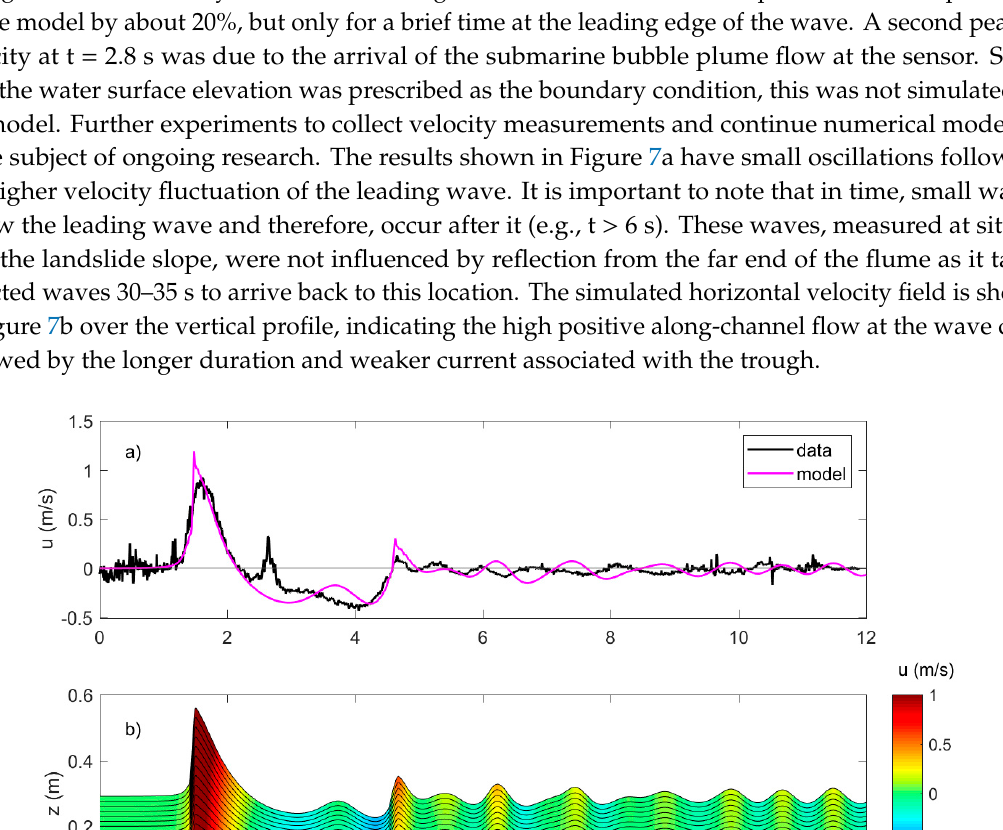
Figure 7. Along-flume fluid velocity time series at probe P2 during the wave passage for the high landside mobility case: ( a ) observed and predicted near-bottom velocity; ( b ) simulated water surface elevation and color contours of horizontal velocity, with black lines indicating the vertical grid.